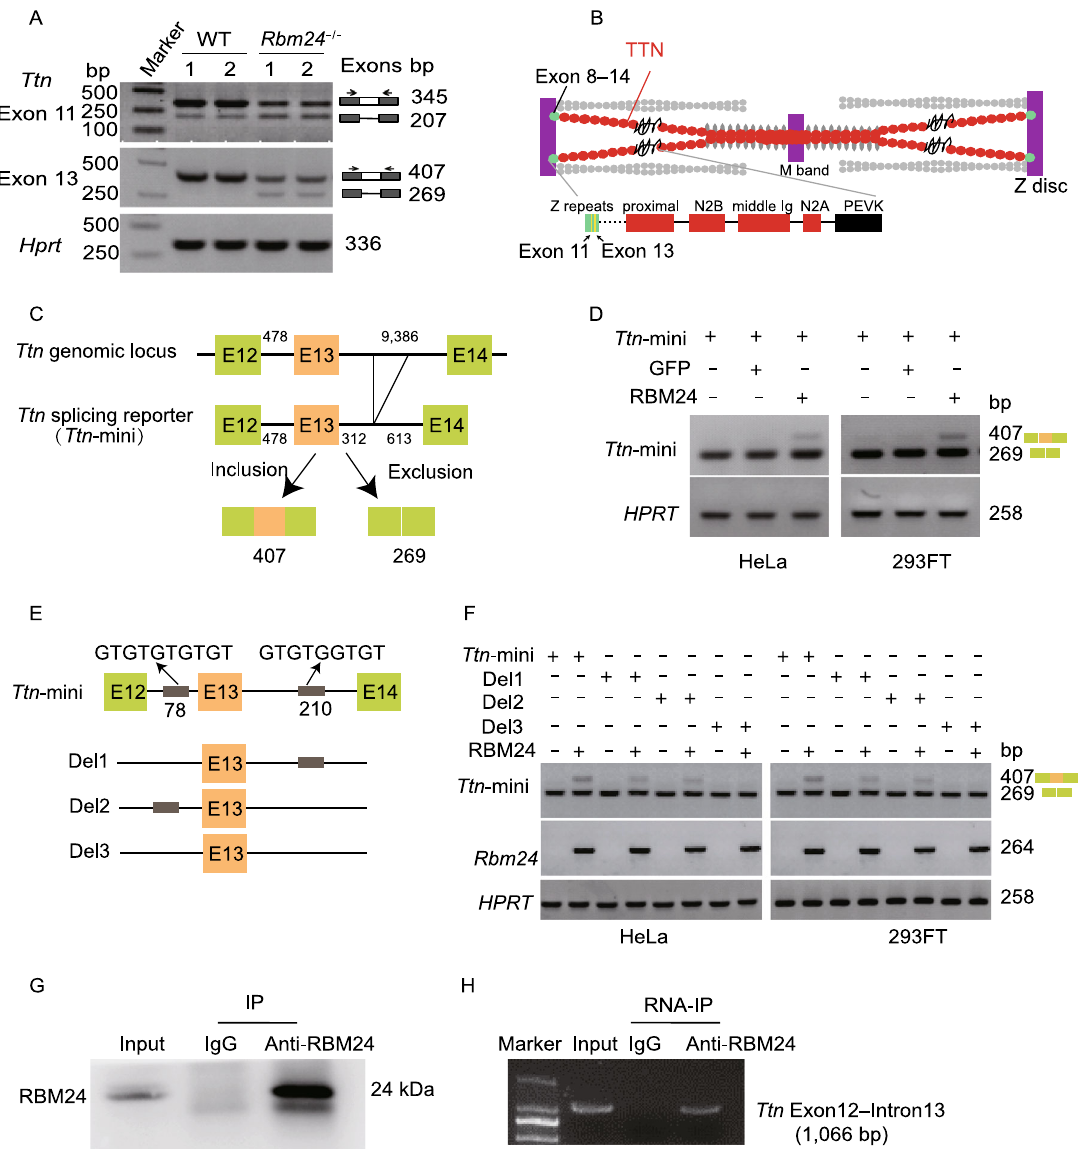
Figure 5. RBM24 regulates Ttn splicing. (A) Splicing analysis for Ttn . Primer locations and expected band sizes are indicated. Data are representative of 5 – 7 independent experiments from 5 – 7 mice. (B) A schematic of TTN structure. A single TTN molecule spans from Z-disc to the M-band. The structure annotation of TTN is indicated based on Roberts et al. (2015) and Anderson and Granzier (2012). (C) Schematic of Ttn splicing reporter ( Ttn -mini) constructed based on Ttn genomic locus. The lengths of exons and introns are indicated. (D) RT-PCR analysis of the splicing pattern of Ttn -mini after transfection into HeLa and 293FTcells. (E) Schematic of exon 13 and the fl anking introns of Ttn -mini. Two clusters of GT stretches located in introns upstream (cluster 1) and downstream (cluster 2) of exon 13 are indicated. Schematic of constructs with deletion of cluster 1 (Del1), cluster 2 (Del2) or both (Del3) from the Ttn -mini reporter are also shown. (F) RT-PCR analysis of RNA splicing in HeLa and 293FT cells transfected with the indicated plasmids. (G) Western blot analysis for RNA-IP experiments using anti-RBM24 antibody. RNA-IP was performed using anti-RBM24 antibody or a IgG negative control. (H) The enrichment of Ttn pre-mRNA showed in our experiment. RT-PCR analysis of RNAs isolated in RNA IP experiment in (G). RNA was reverse transcribed and quanti fi ed with RT-PCR using Ttn speci fi c primers designed for 1,066 bp amplicon from exon12 – intron13 region. Hprt was used as an internal control (A, D and